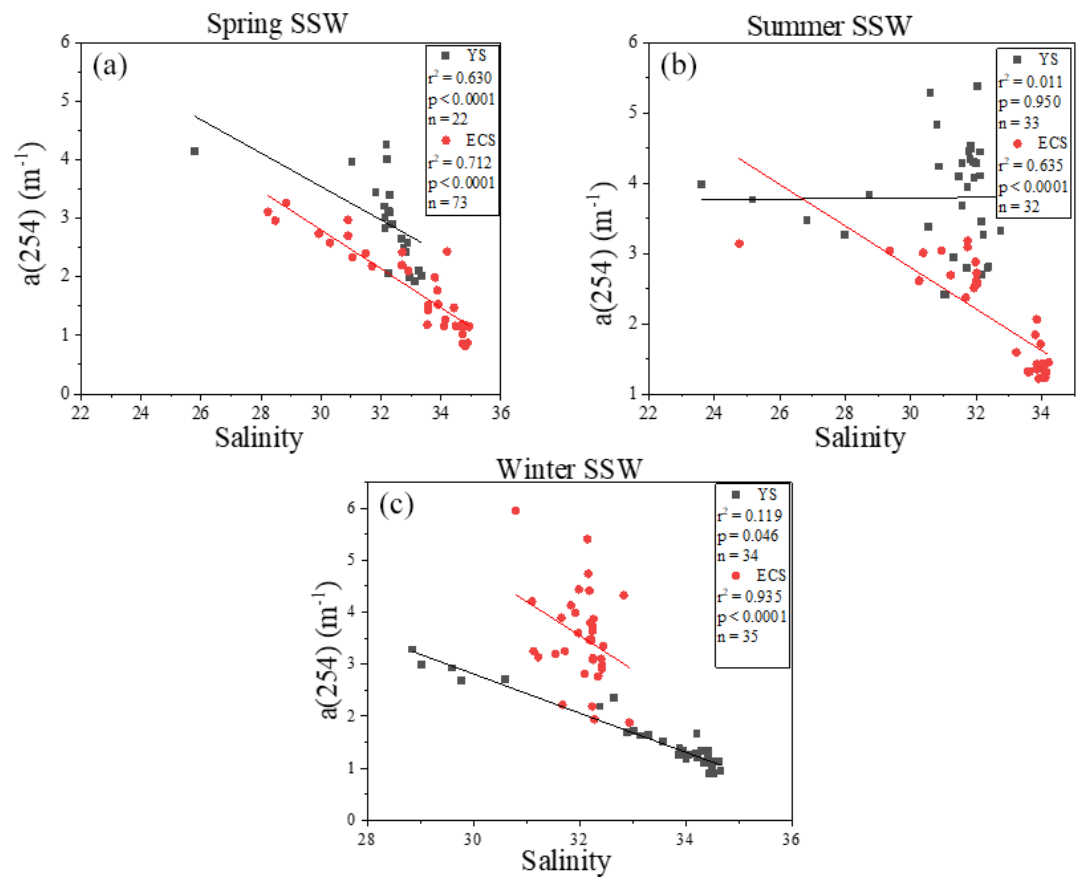
Figure 3. Relationships between a (254) and salinity in the sub-surface water (SSW) in the East China Sea (ECS) and the Yellow Sea (YS) during spring, summer and